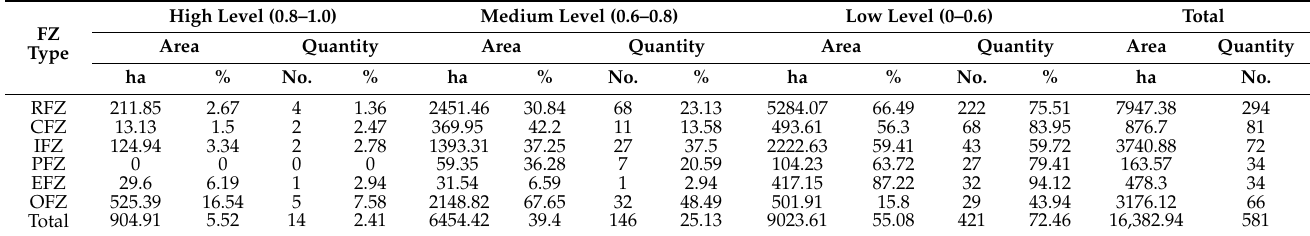
Table 4. Results of ecological intensity in